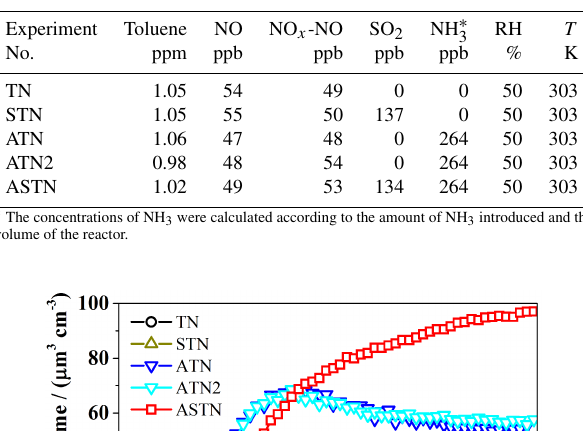
Table 1. Initial experimental conditions of toluene / NO x photooxi- dation in the presence or absence of SO 2 and/or NH 3 .